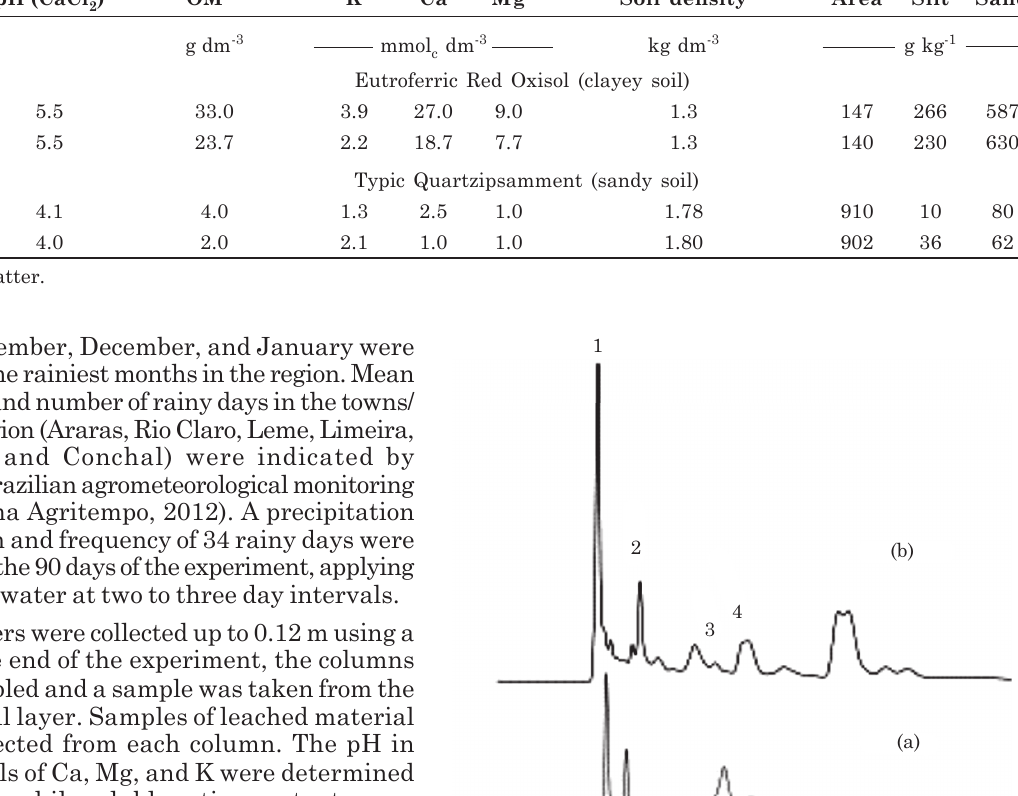
Table 1. Chemical and physical characteristics of Latossolo Vermelho eutrófico (eutroferric Red Oxisol) (clayey soil) and Neossolo Quartzarênico (Typic Quartzipsamment) (sandy soil) subjected to vinasse and basalt powder treatments Depth